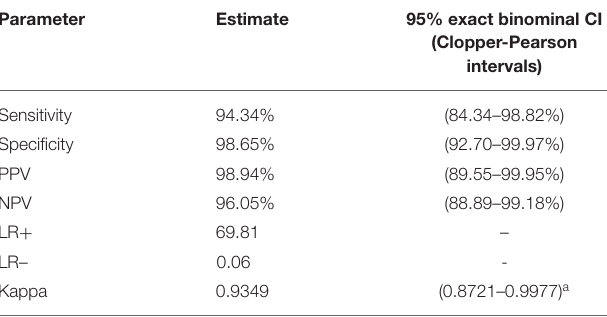
TABLE 2 | Estimated diagnostic parameters with 95%